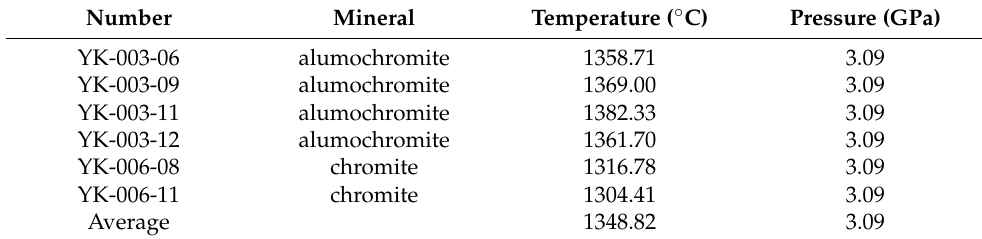
Table 6. Temperature and pressure of the chromite core in “Laoshan Jade”.